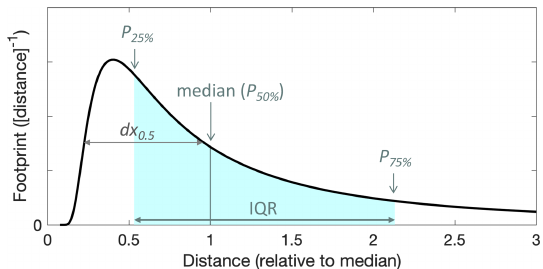
Figure 9. Cross-wind integrated flux footprint obtained from the footprint parametrization described in Kljun et al. (2015) as a func- tion of horizontal upwind distance from the measurement loca- tion and referenced to the footprint distribution’s median ( P 50% ). Marked in blue is the interquartile range, IQR, spanning from the 25th to the 75th percentiles ( P 25% and P 75% ), which we used for illustrating flux footprint locations and dimensions in subse- quent georeferenced figures. The half-width of the function, dx 0 . 5 , is pointed out as well.